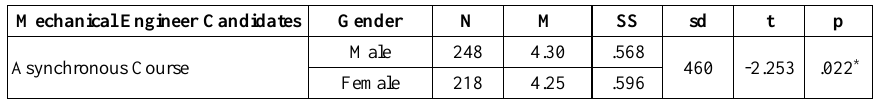
Table 6. Distribution of mechanical engineer candidates’ asynchronous course status according to gender